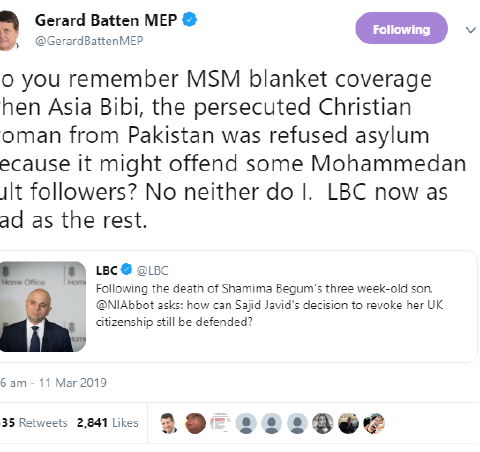
Figure 8. Tweet from UKIP leader Gerard Batten, 11 March 2019.